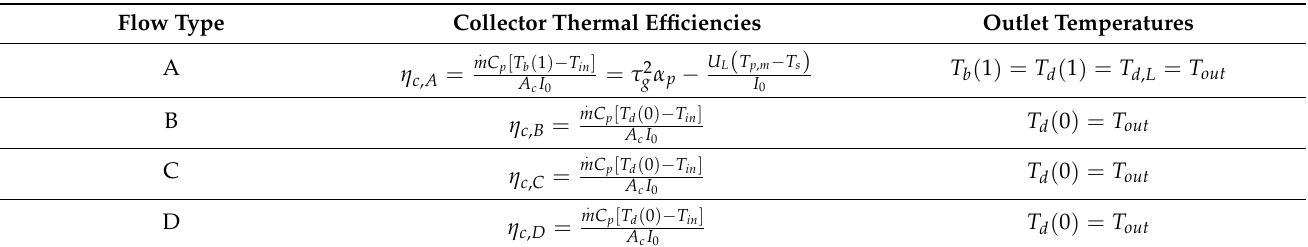
Table 3. Theoretical predictions of the collector thermal efficiencies and outlet temperatures for Type A to Type D.